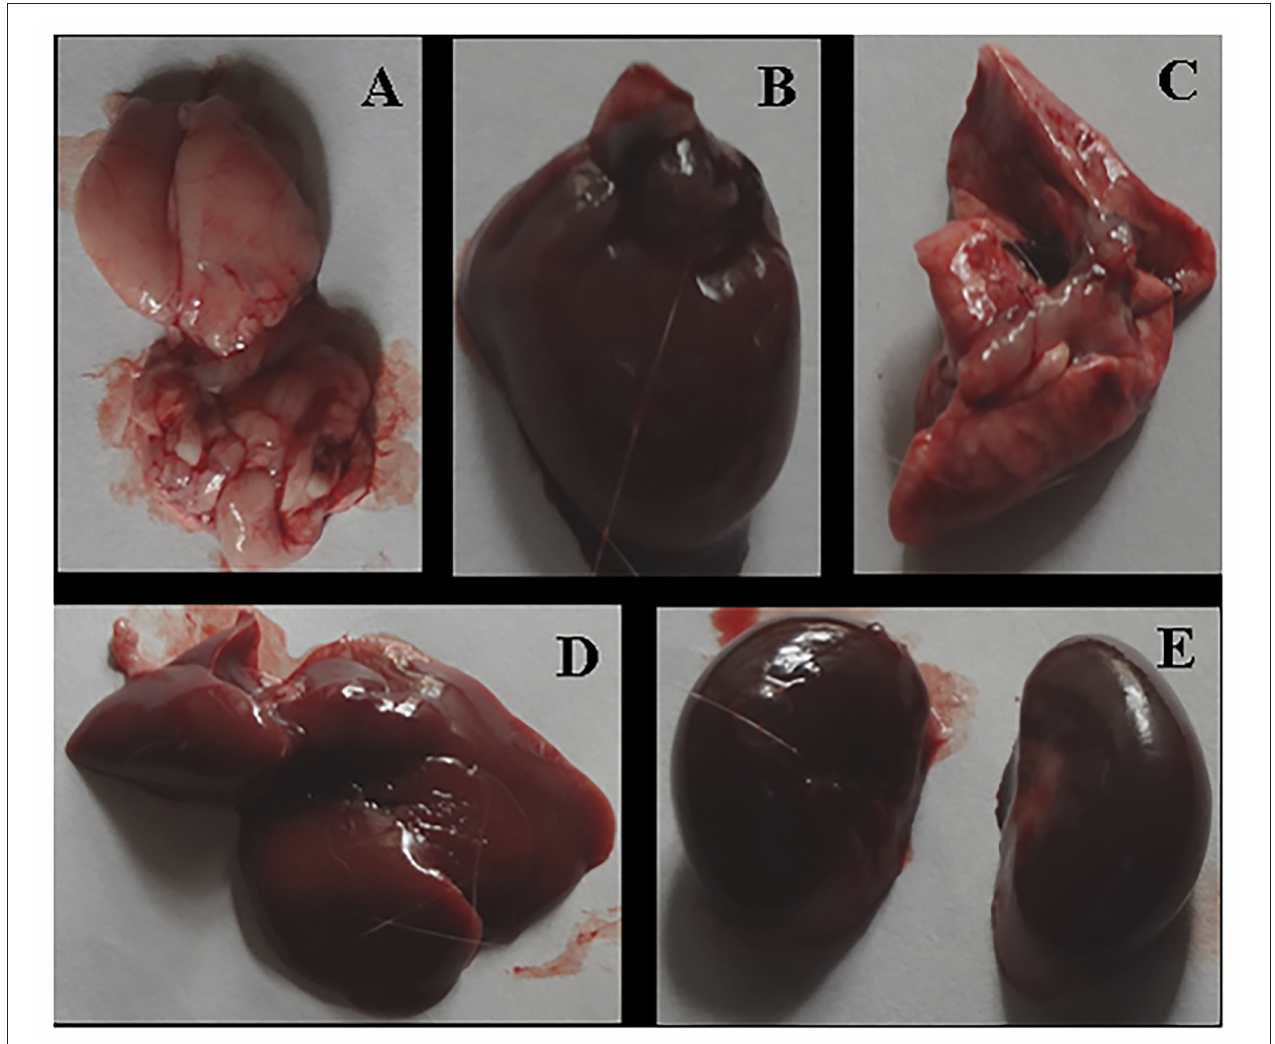
FIGURE 6 | Gross necropsy of albino Wistar rat, organs of untreated (Group F) animal [ (A) Brain, (B) Heart, (C) Lung, (D) Liver, (E)